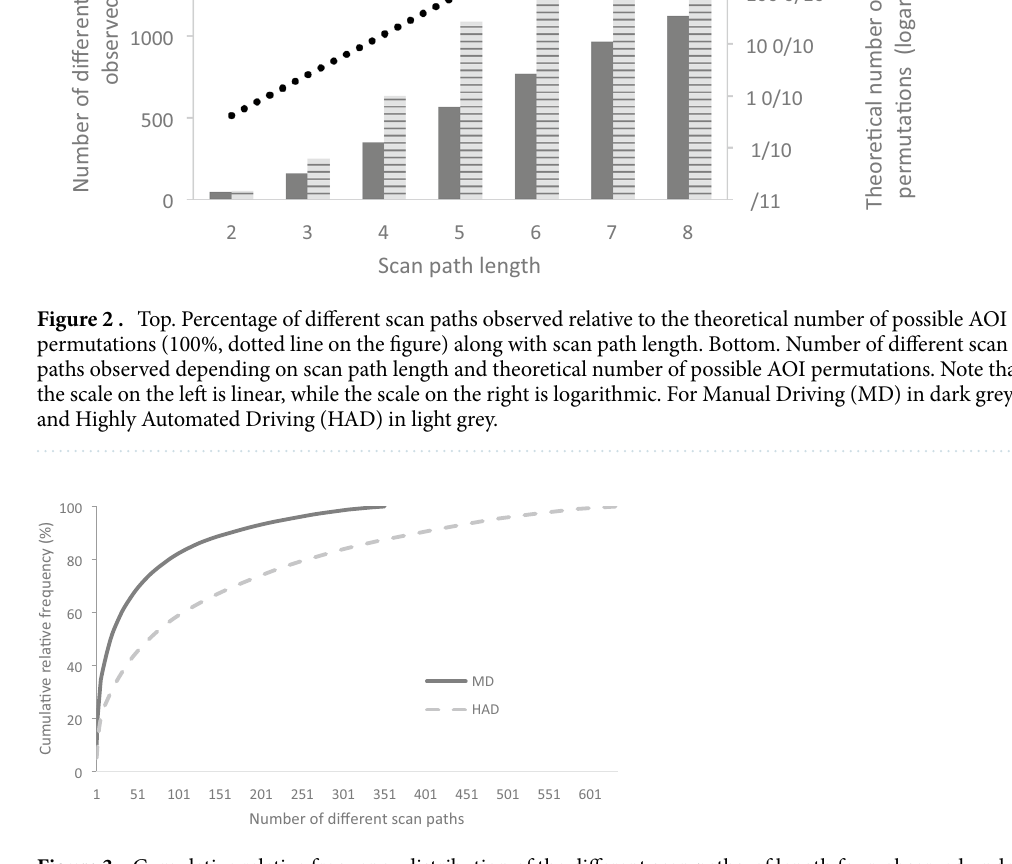
Figure 3. Cumulative relative frequency distribution of the different scan paths, of length four, observed under Manual Driving (MD) and Highly Automated Driving